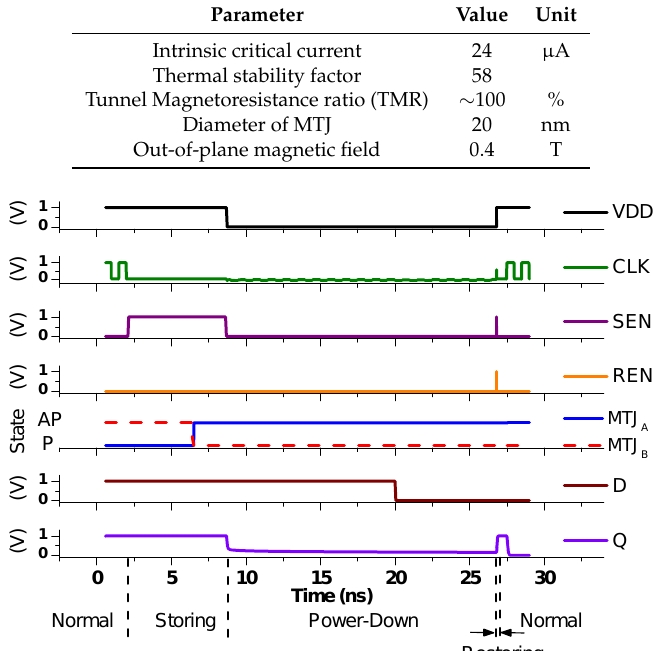
Table 1. Key parameters of perpendicular magnetic tunnel junction (MTJ) [6–8].